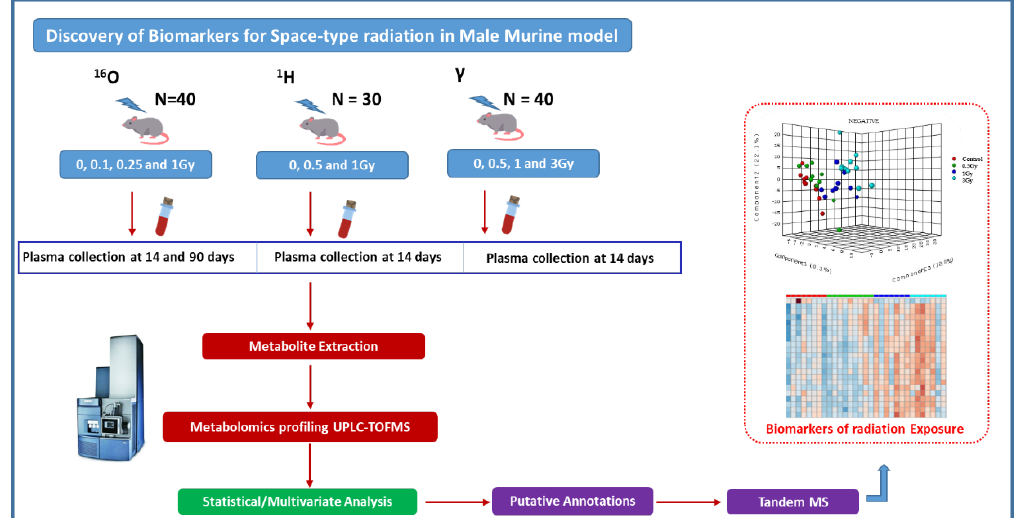
Figure 1. Workflow of plasma metabolomics using male C57BL/6J mice exposed to sham or low doses of space type radiation.